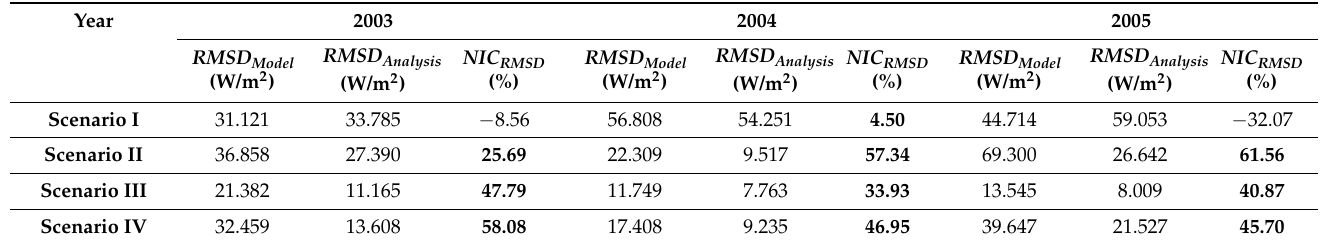
Table 3. NIC RMSD of latent heat fluxes in different assimilation scenarios (I–IV) in 2003, 2004, and 2005. Positive NIC RMSD numbers are marked in